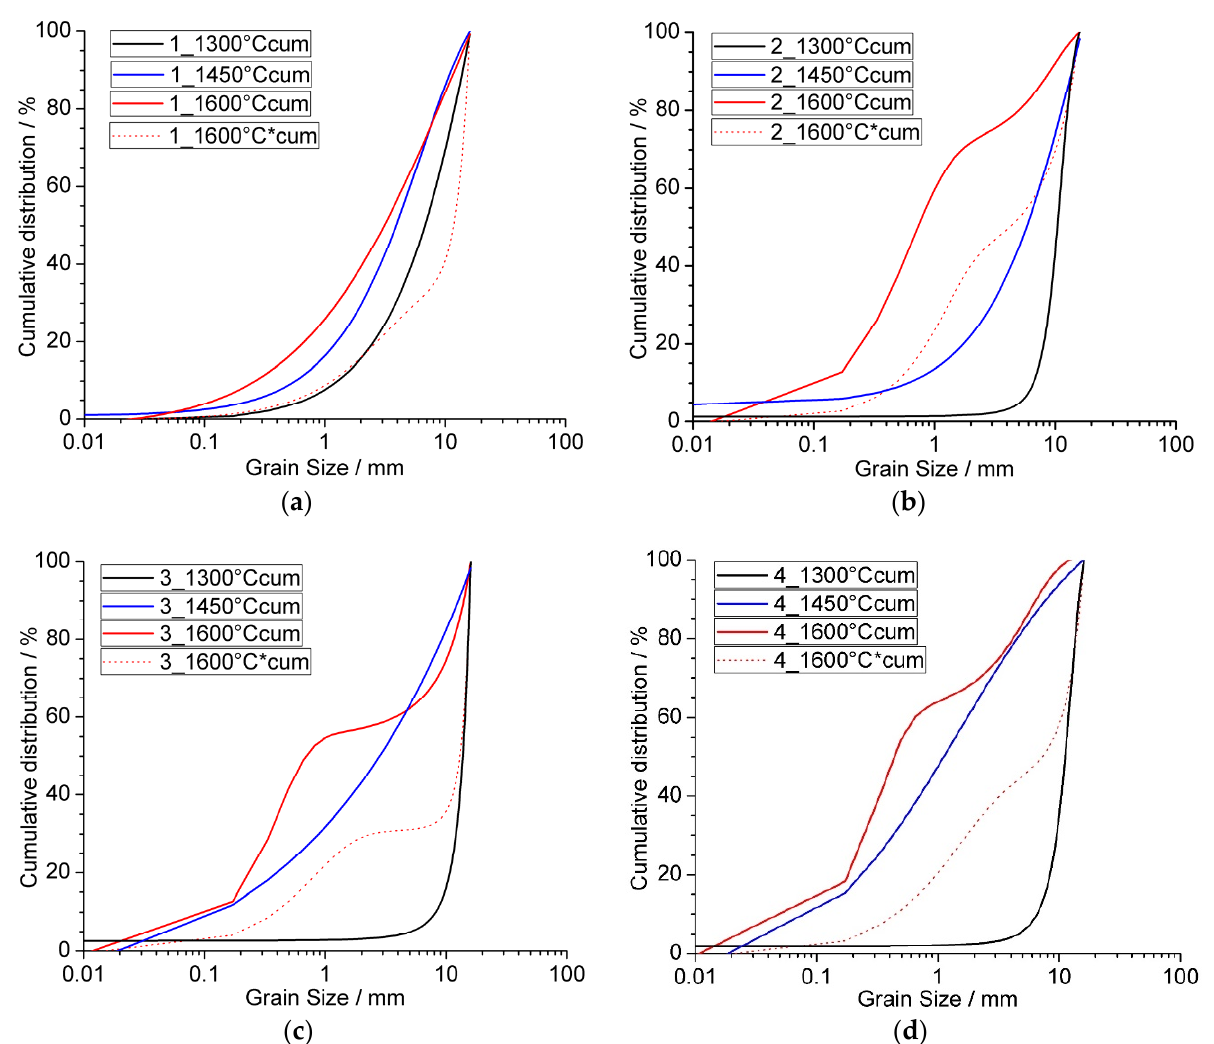
Figure 7. Cumulative curves after thermal and mechanical stressing of quartzes. ( a ) Quartz Slovakia ; ( b ) quartz Spain ; ( c ) quartz Russia ; ( d ) quartz Macedonia.